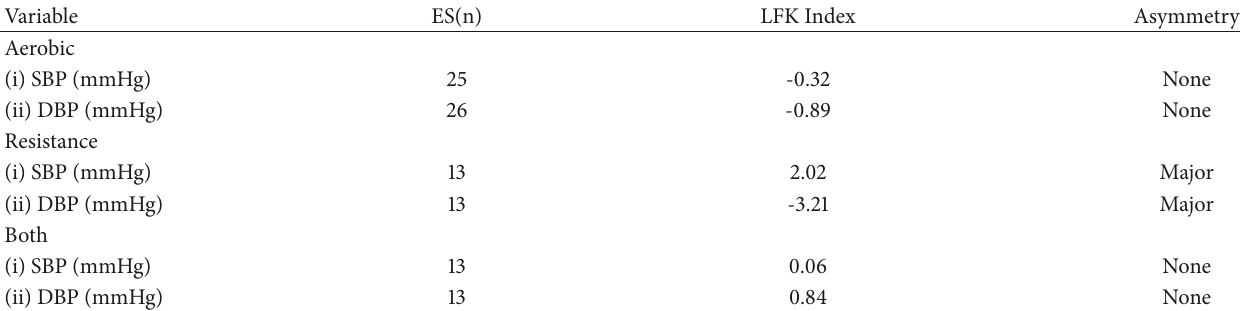
Table 2: Summary of Doi plot results for asymmetry, i.e., small study effects, based on changes in resting systolic and diastolic blood pressure. Variable